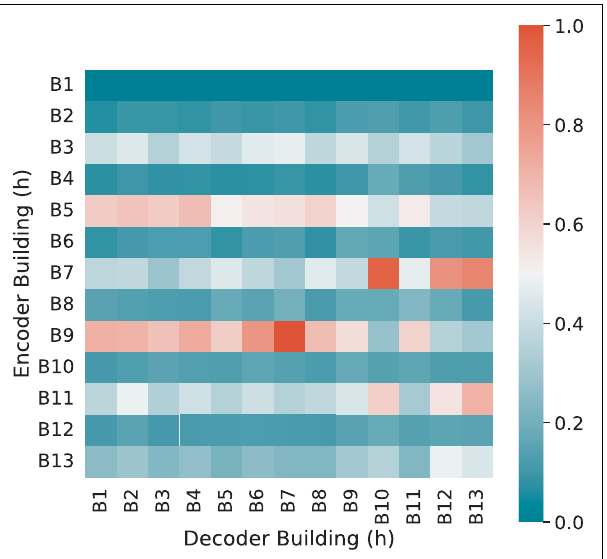
FIGURE 6 | Heatmap of attention weights aggregated per entity. The horizontal axis represents the entity being input, and the vertical axis denoted the entity being predicted.